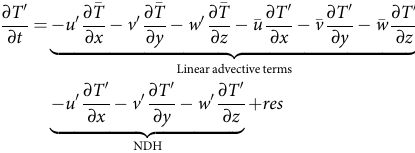
timestep i , N the number of monthly timesteps, and σ ¼ deviation. We de fi ned ENSO ’ s amplitude and asymmetry as the standard deviation and skewness of the detrended Niño-3 SST anomalies (unit: K). The zonal wind stress anomaly is averaged over a central-Paci fi c domain (150°E – 120°W, 5°S – 5°N; unit: N m − 2 ). The shortwave- and longwave radiative surface heat fl ux anomalies are averaged over the Niño-3 and Niño-4 regions (160 ˚ E – 90°W, 5°S – 5°N; unit: W m − 2 ). The zonal contrast of shortwave heat fl ux ( Δ x SW) used in Fig. 2c is the difference between the shortwave anomalies in the western (140° – 170°E) and eastern (140° – 170°W) boxes between 5°S and 5°N. ENSO feedback is de fi ned as the regression coef fi cient of a speci fi c anomalous fi eld onto the Niño-3 SST anomaly and the feedback asymmetry is measured by the difference between regression coef fi cients for positive and negative Niño-3 SST anomalies. The NDH consists of the nonlinear advective terms in the following equation: